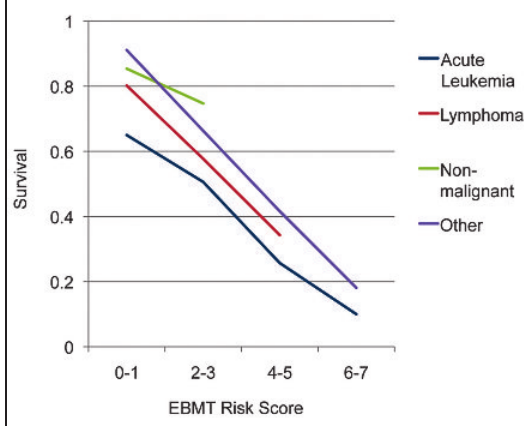
Survival probability at 5 years depending of the EBMT risk score in the different main disease categories. Acute leukaemia, Lymphoma = lympho- proliferative disorders, Nonmalig- nant = nonmalignant diseases, Other = all other